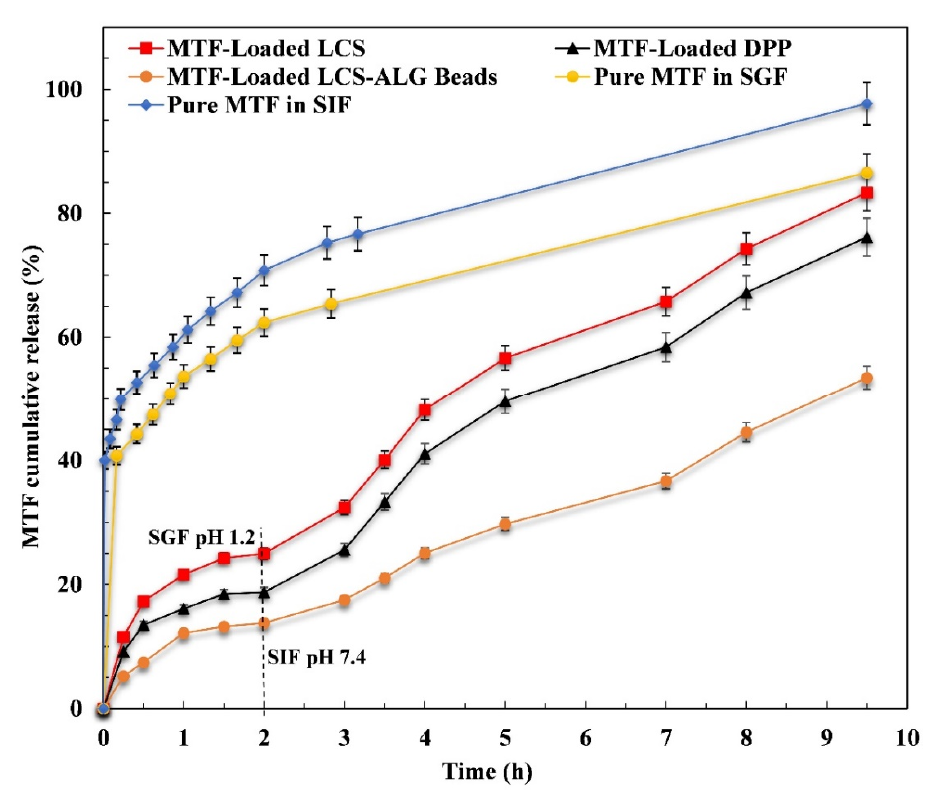
Figure 6. In vitro release profile of pure MTF and that released from MTF-loaded LCS, MTF- loaded DPP, and MTF-loaded LCS-ALG beads in different pH media at 37 ± 0.5 °C. Values are DPP, and MTF-loaded LCS-ALG beads in different pH media at 37 ± 0.5 ◦ C. Values are presented as presented as mean ± SE, ( n = 3). mean ± SE, ( n =